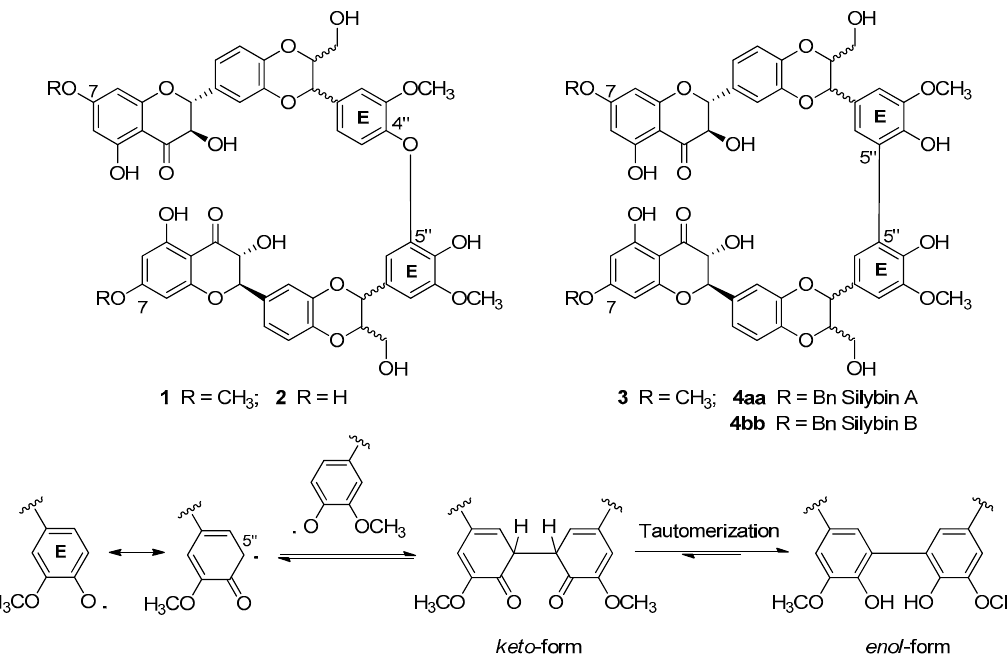
Figure 3. First bi -flavonolignans from silibinin oxidation and the mechanism of 5 ′′ -5 ′′ bond formation.